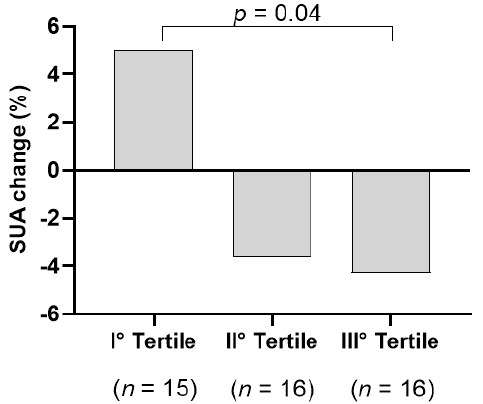
Figure 2. SUA change according to severity of hepatic steatosis at baseline. *Adjusted for